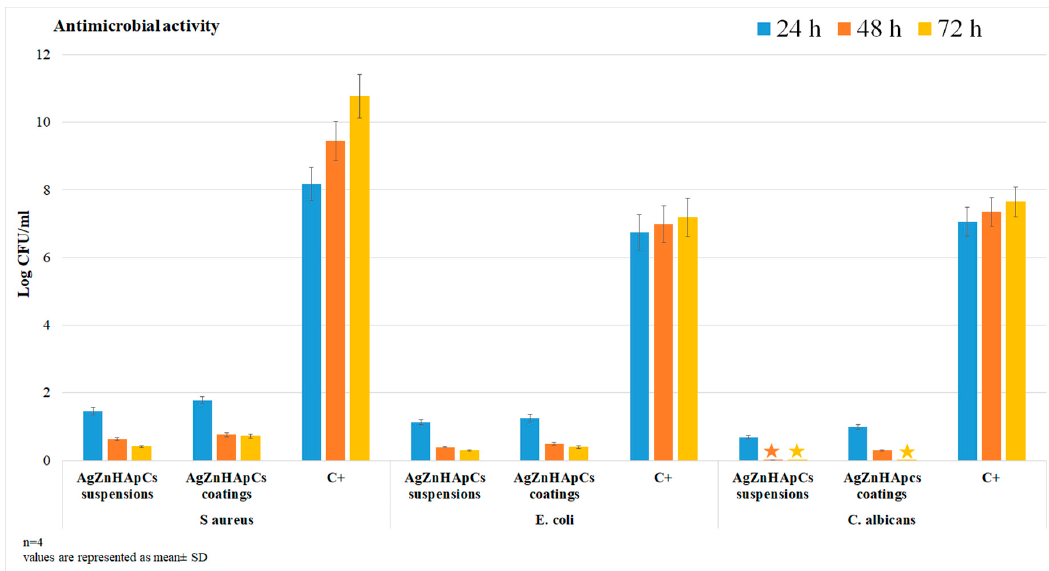
Figure 10. The graphical representation of the Log colony forming units (CFU)/mL of S. aureus ATCC 25923, E. coli ATCC 25922, and C. albicans ATCC 9002 for different incubation times with AgZnHApCs suspensions and coatings. The results are presented as means ± standard error of the mean of 4 independent experiments. The data was statistically analyzed by ANOVA Single Factor algorithm and the calculated p -values were less than 0.0001.